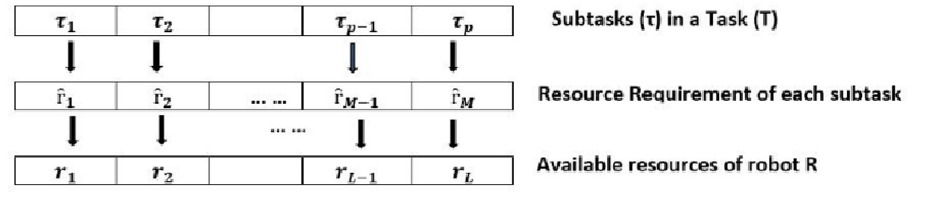
Fig 3. Mapping of subtask’s requirement with available resources of the